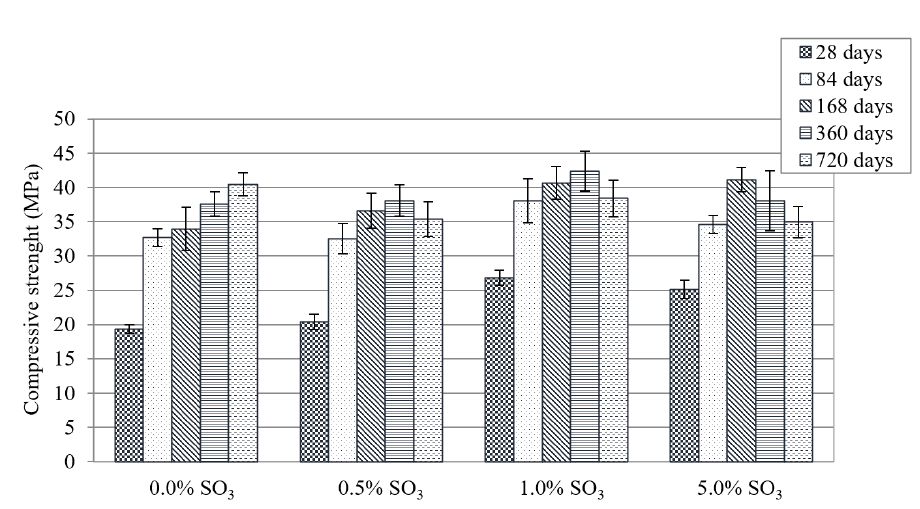
Figure 4. Compressive strength monitoring for the series (0.0%, 0.5%, 1.0% and 5.0% SO 3 ).